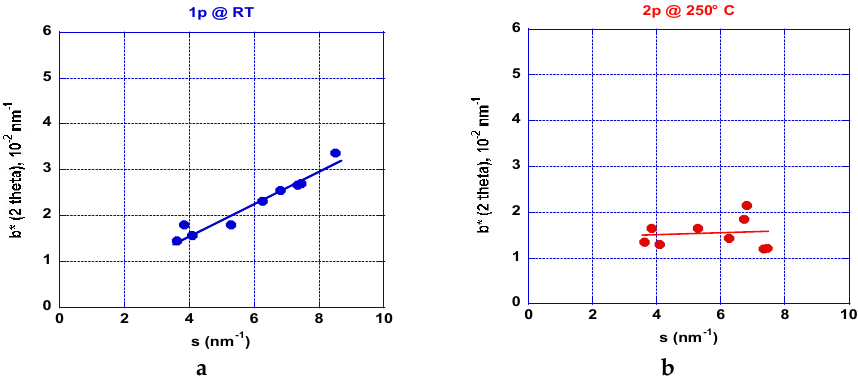
Figure 15. Williamson-Hall [44] plots allow for the study of the impact of temperature processing AZ31 billets submitted to A-type ECAP passes: ( a )—marked strained material with a mean small size of crystallites of 300-400 nm for 1 pass at RT, ( b )—2 passes at 250 K, which revealed almost no strain in spite of a marked anisotropic distribution and a minimum mean size of crystallites (<100 nm).